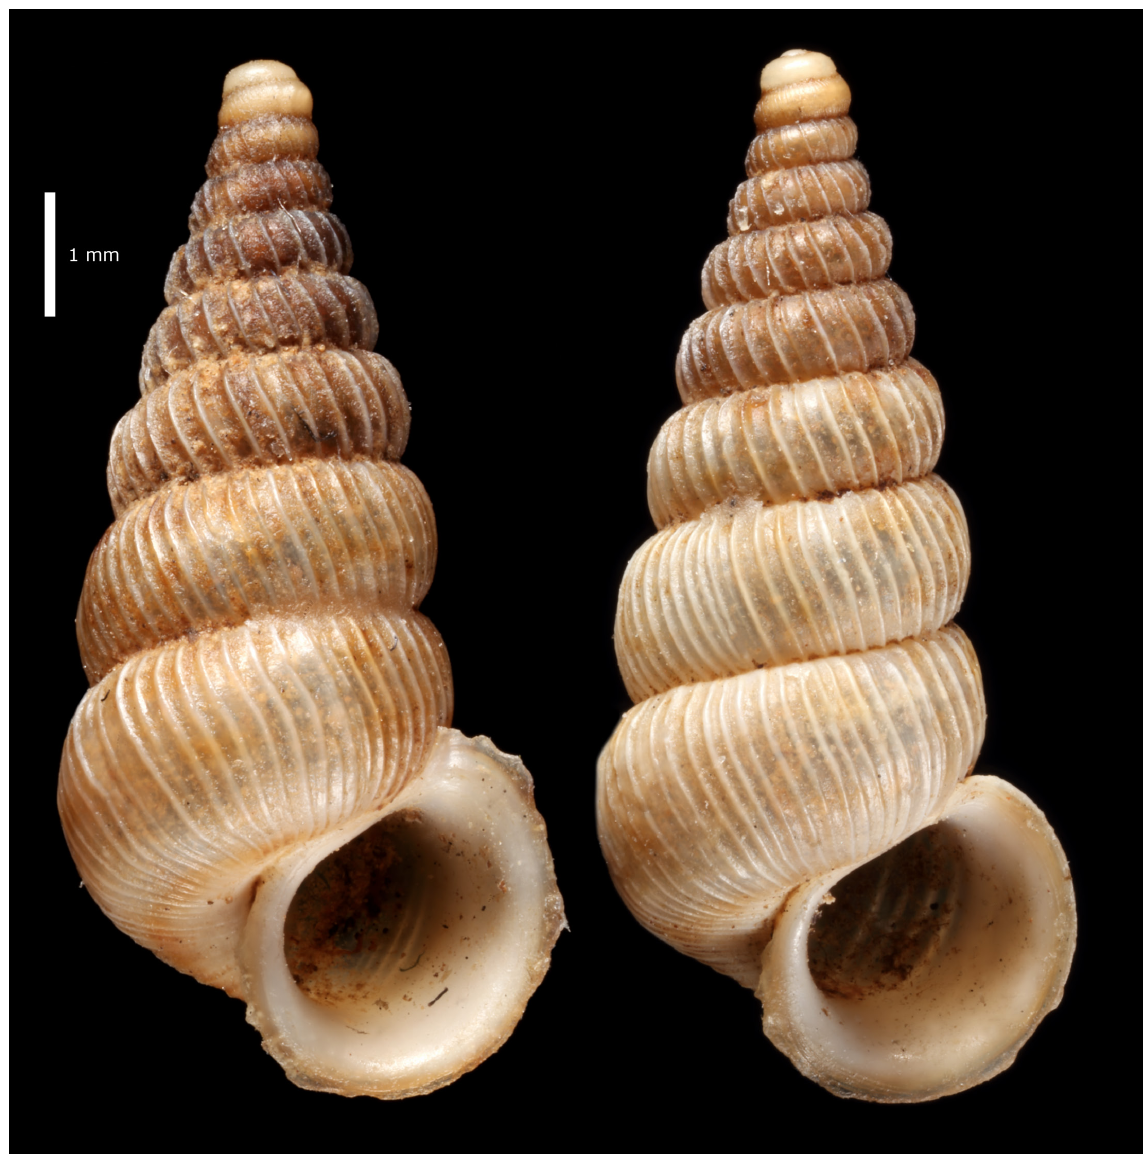
Fig. 20. Cochlostoma ( Clessiniella ) villae (Strobel, 1851), syntypes, ♂♂, at the Museo di Storia Naturale of Parma University, Italy (1610-C2, left; 1610-C3,